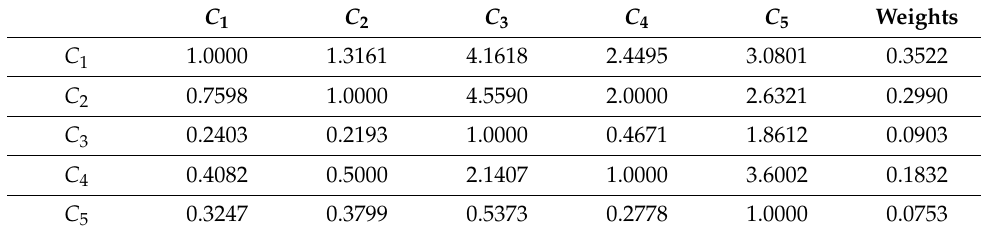
Table 3. Pairwise comparison matrix between the criteria within the Individual dimension.